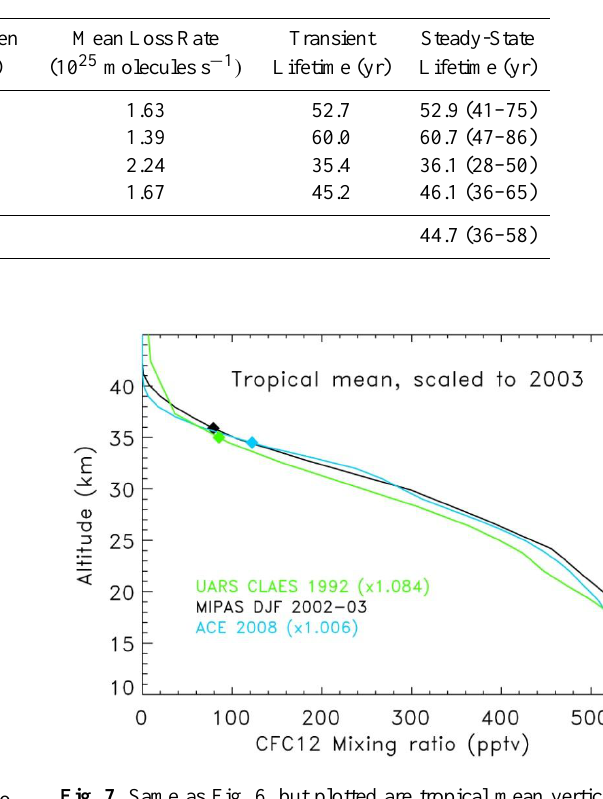
Fig. 6. Tropical mean vertical profiles of CFC-11 mixing ratio from CRISTA-1 (green), CRISTA-2 (red), MIPAS (black), and ACE (blue), all scaled to a tropospheric mean mixing ratio of 269 ppt using altitude independent factors for comparison. Scaling factors are given in the figure legend. Diamond symbols represent the mean top of measured profiles for each instrument; profiles above these levels are cubic spline extrapolations to zero mixing ratios as described in the text.